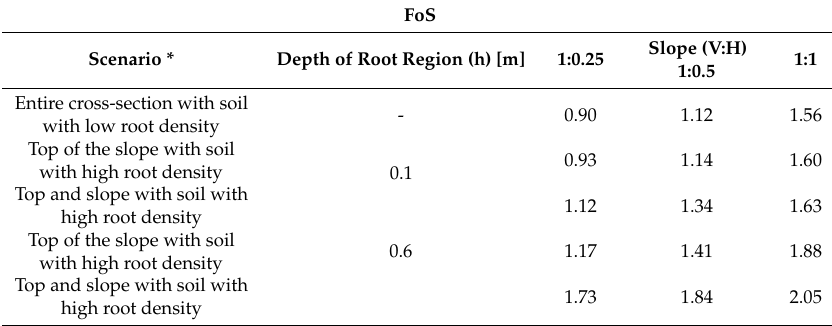
Table 6. Values of factor of safety (FoS) for the three ditch bank slopes and two depths of root region